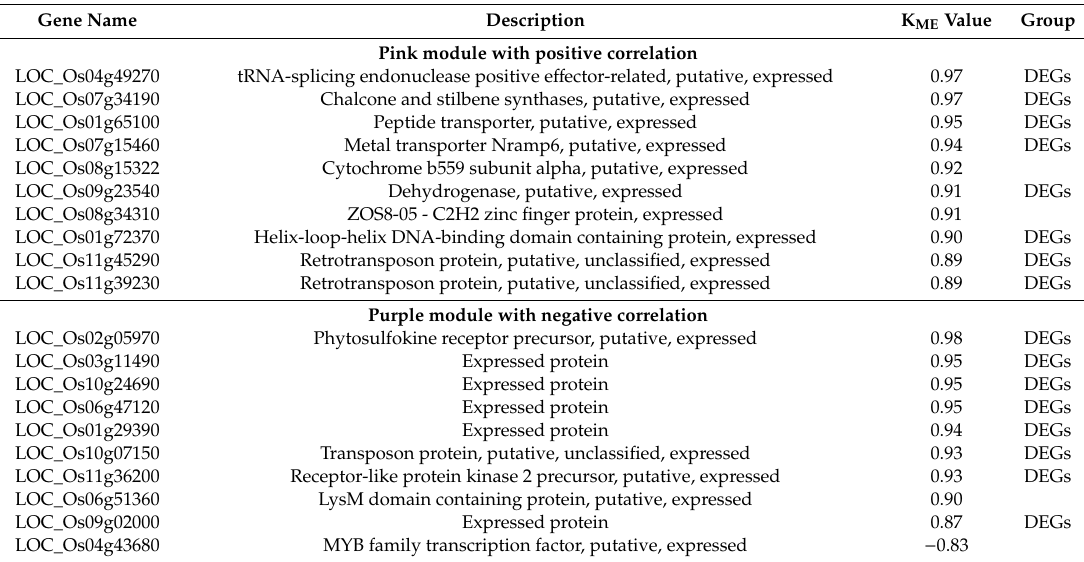
Table 3. Candidate hub genes associated with the size of